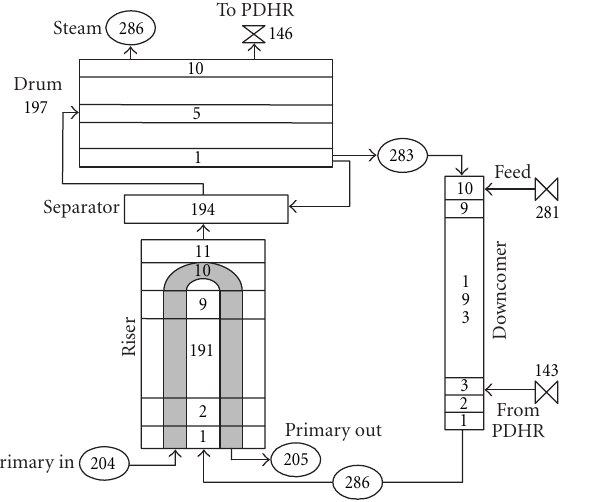
Figure 5: Steam generator nodalisation.